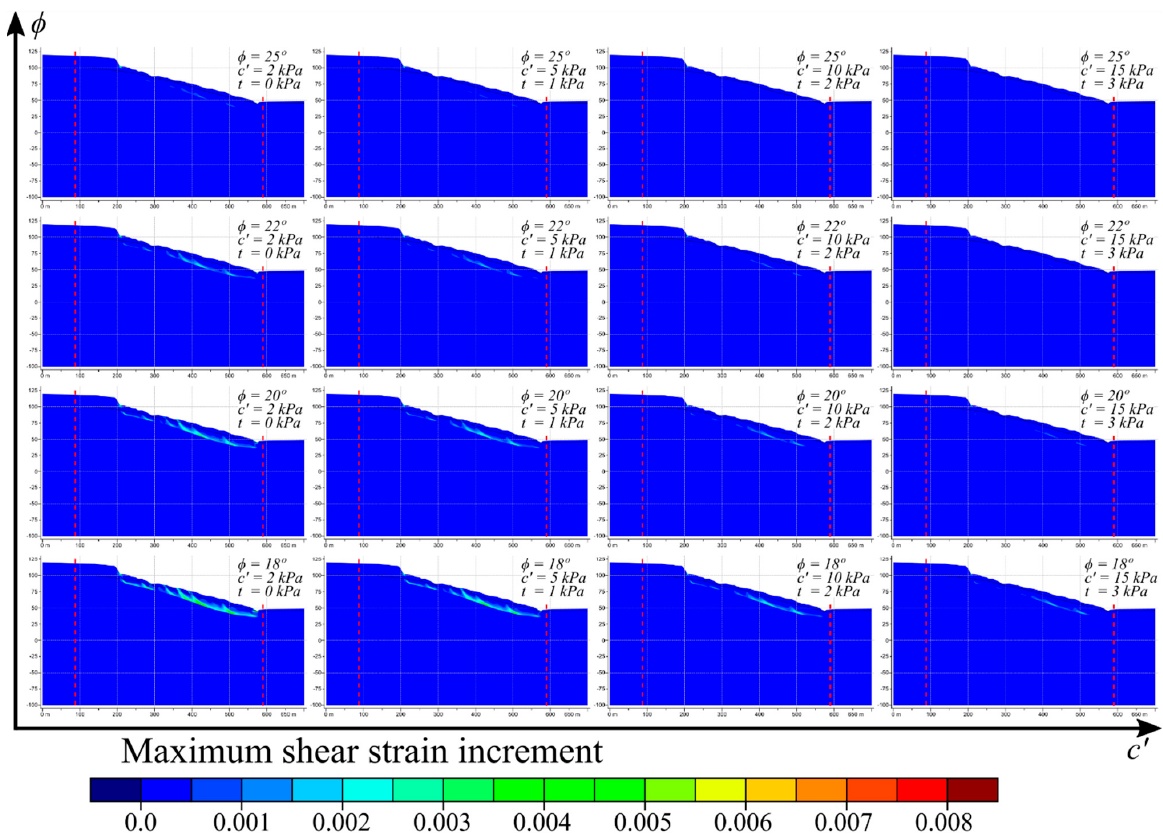
Figure 12. Sliding surface depicted based on the maximum shear strain increments distribution. (high-resolution image available at https://doi.org/10.6084/m9.figshare.14920128.v2).